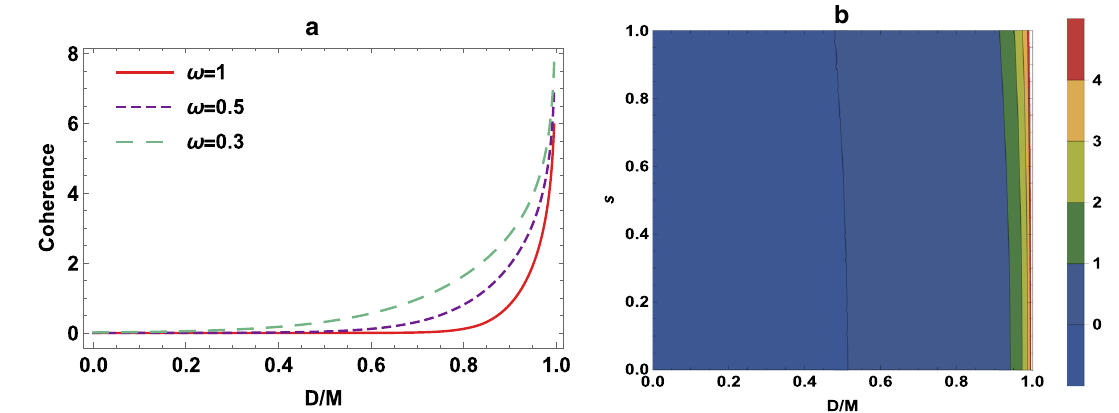
Bob and anti-Bob versus the squeezing parameter s and the ratio D / M